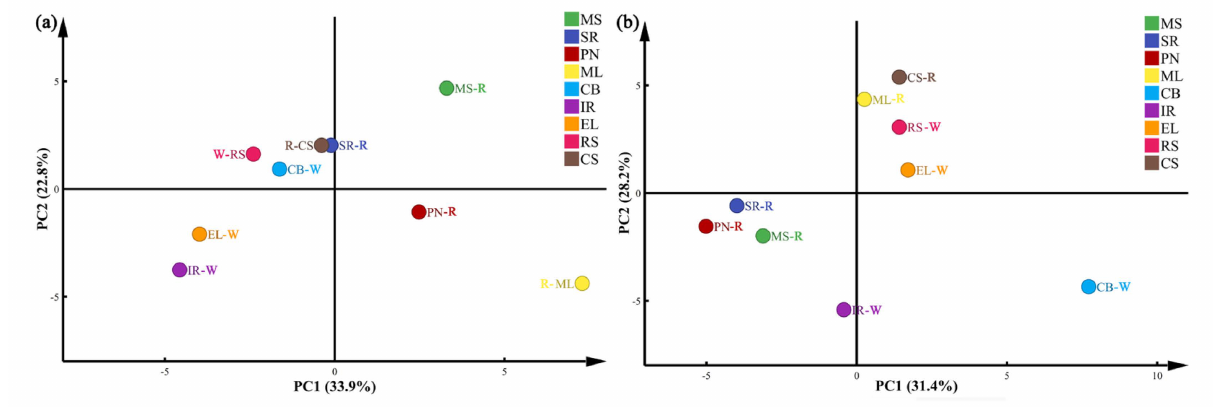
Figure 7. Principal component analysis (PCA) scatter plot of the fungal ( a ) and bacterial communities ( b ) in the